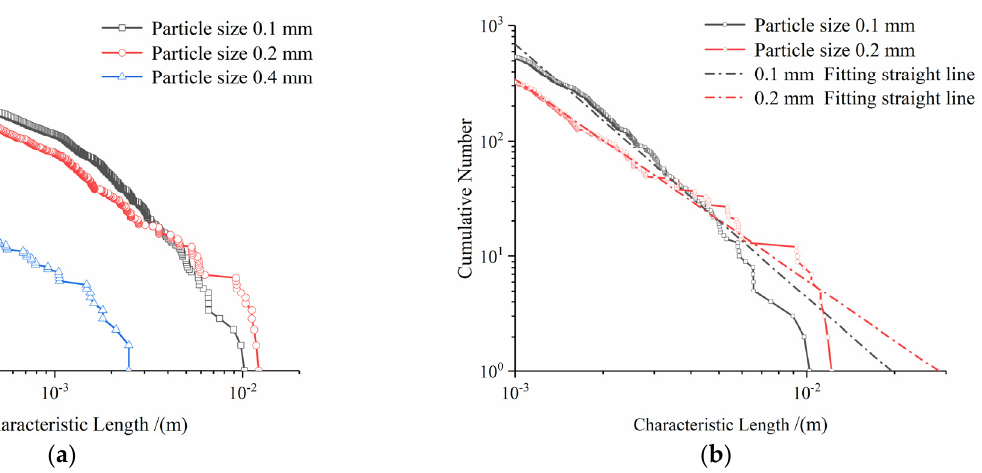
Figure 9. Characteristic length distribution of debris fragments under different particle sizes. ( a ) Characteristic length distribution of debris fragments under three particle sizes; ( b ) characteristic length (>10 − 3 m) distribution of debris frag- ments in the case of fine particles.